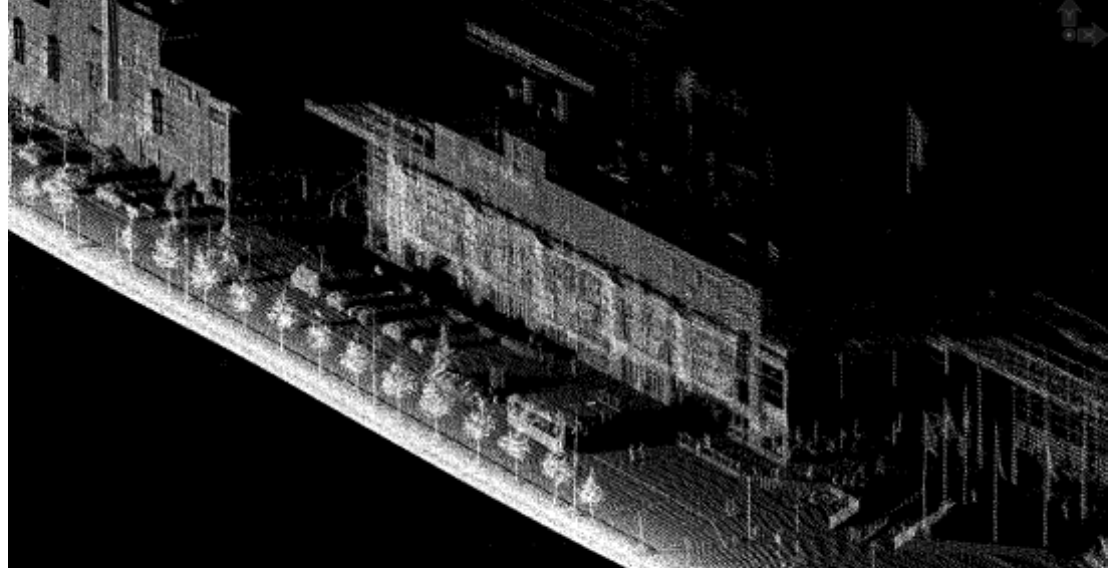
Figure 9. Sensei data. Due to the scanning angle, the Sensei covered only one side of the trajectory at a